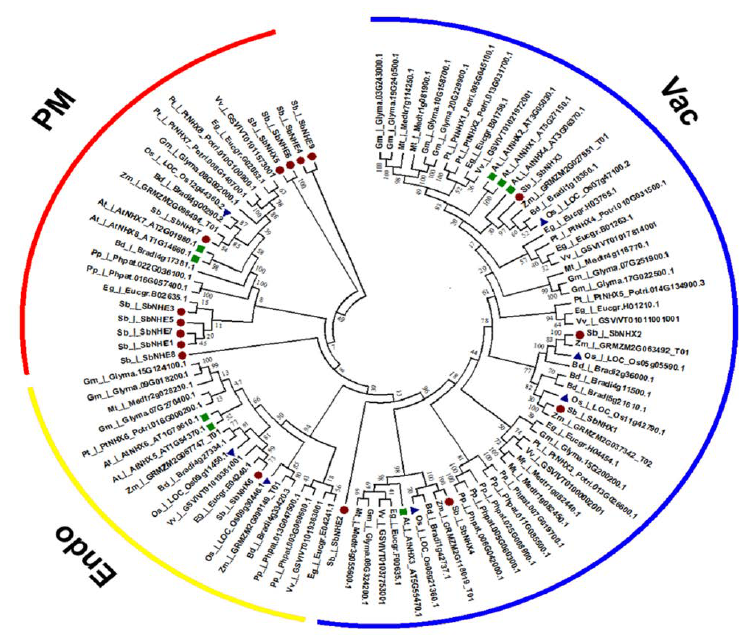
Figure 4. Phylogenetic tree of sodium transporters between Sorghum bicolor (Sb), Populus trichocarpa